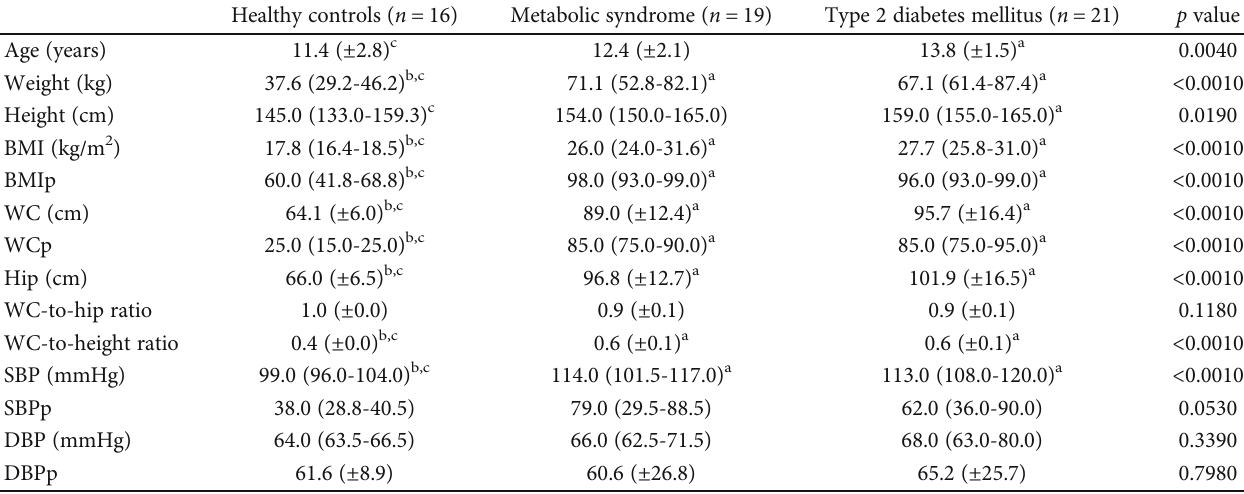
Table 1: Demographic, anthropometric, and clinical characteristics of children and adolescents with type 2 diabetes mellitus, metabolic syndrome, and healthy controls.